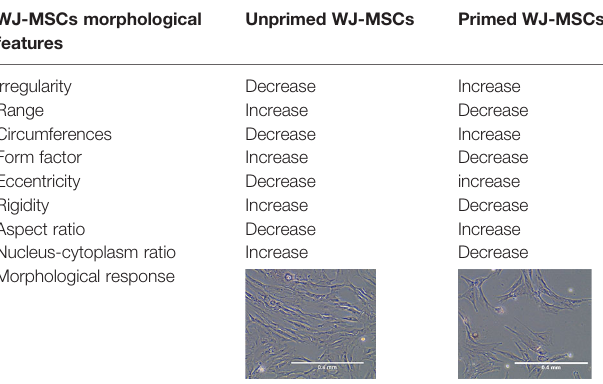
TABLE 3 | Morphological features of WJ-MSCs before and after priming with IFN- g and TNF- a . WJ-MSCs morphological features